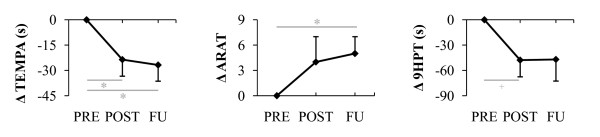
Effects of Armeo Spring training on upper limb functional capacity parameters. Changes in outcome measures (Δ) were measured after 8 weeks of training (POST) and at 2-month follow-up (FU), relative to baseline (PRE).Vertical bars show 1 standard error; *p < 0.05; + trend towards significance.ARAT, Action Research Arm Test; 9HPT, 9-Hole Peg Test.